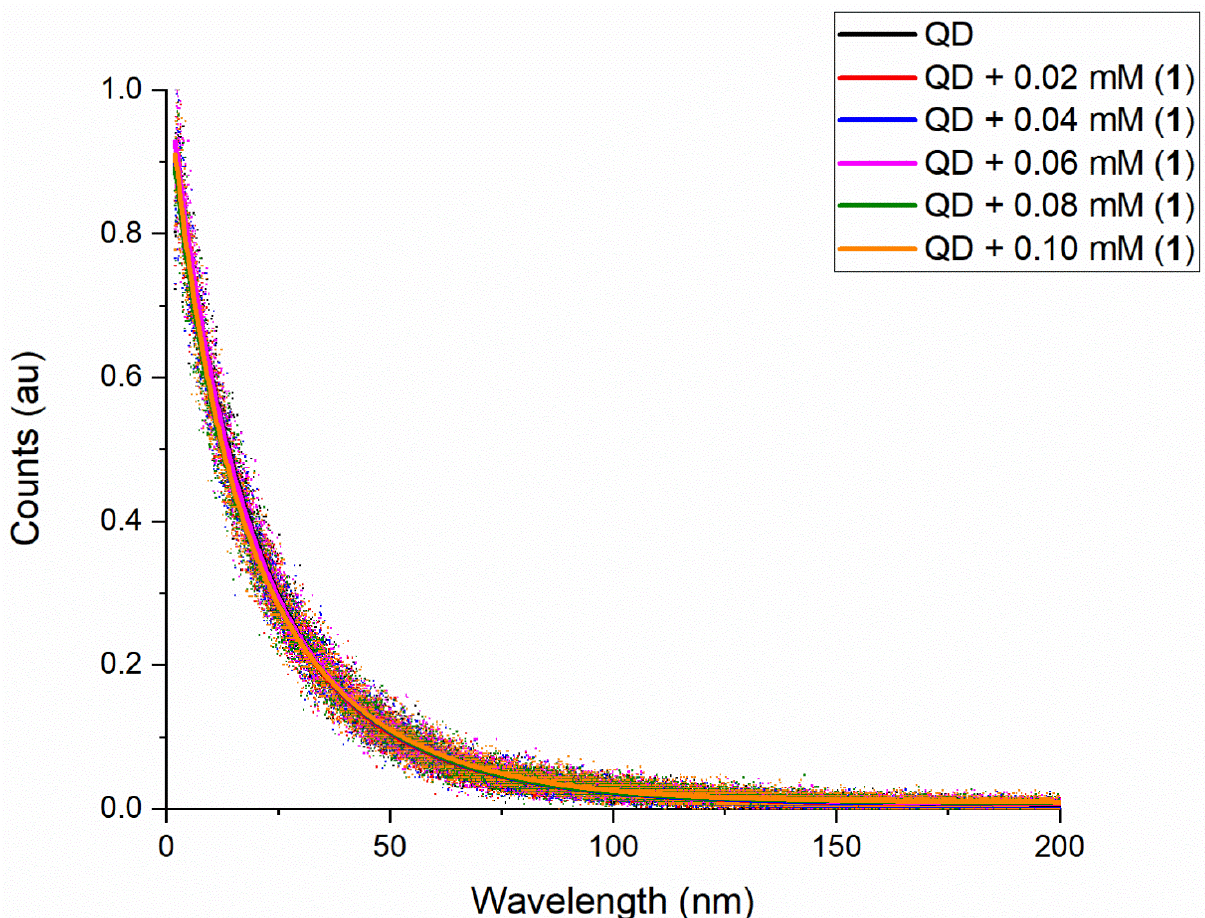
Figure 5. The lifetime of MPA–CdTe quantum dots (1.4 × 10 − 6 M, 0.5 mg/mL) with increasing concentrations of 1 (0 to 0.10 × 10 − 3 M) in water (excitation wavelength: 450 nm).